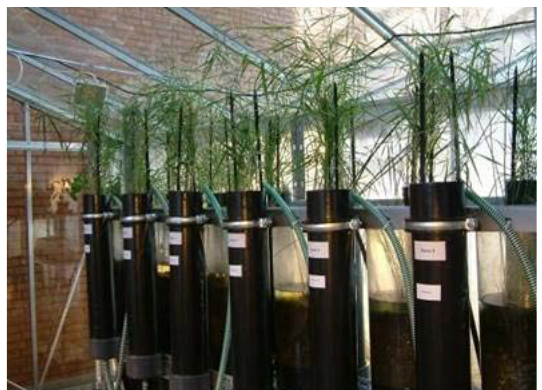
Fig 4. Leaching column experiment for investigating the mobilisation and plant uptake of metals by application of EDTA to